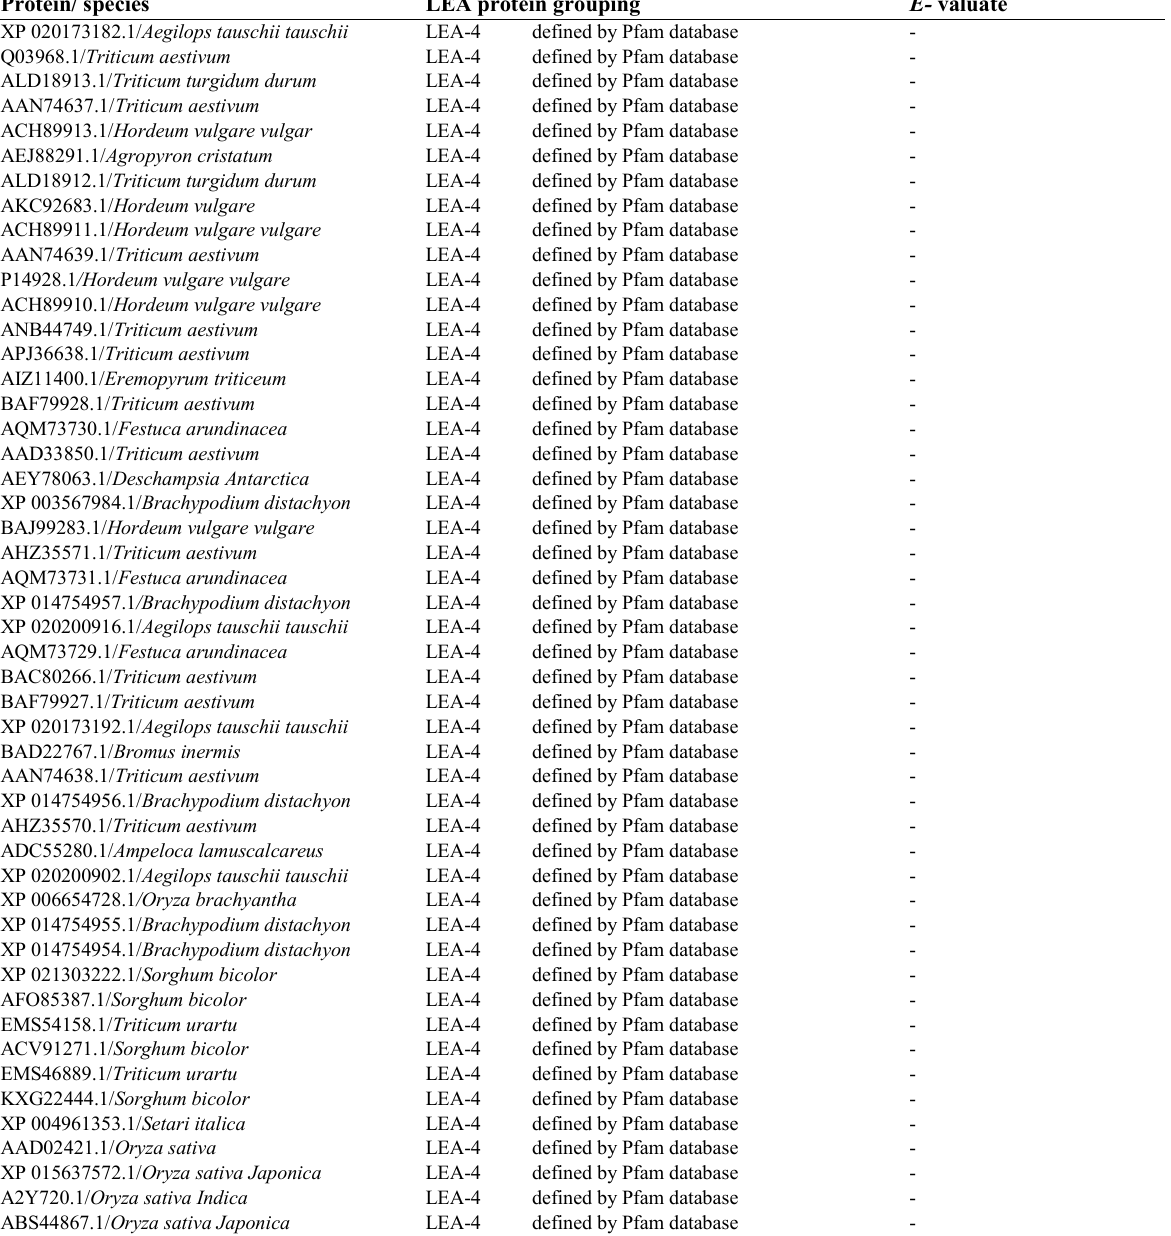
Table 2 : The characteristics of the LEA proteins from Poaceae species. Protein/ species LEA protein grouping XP 020173182.1/ Aegilops tauschii